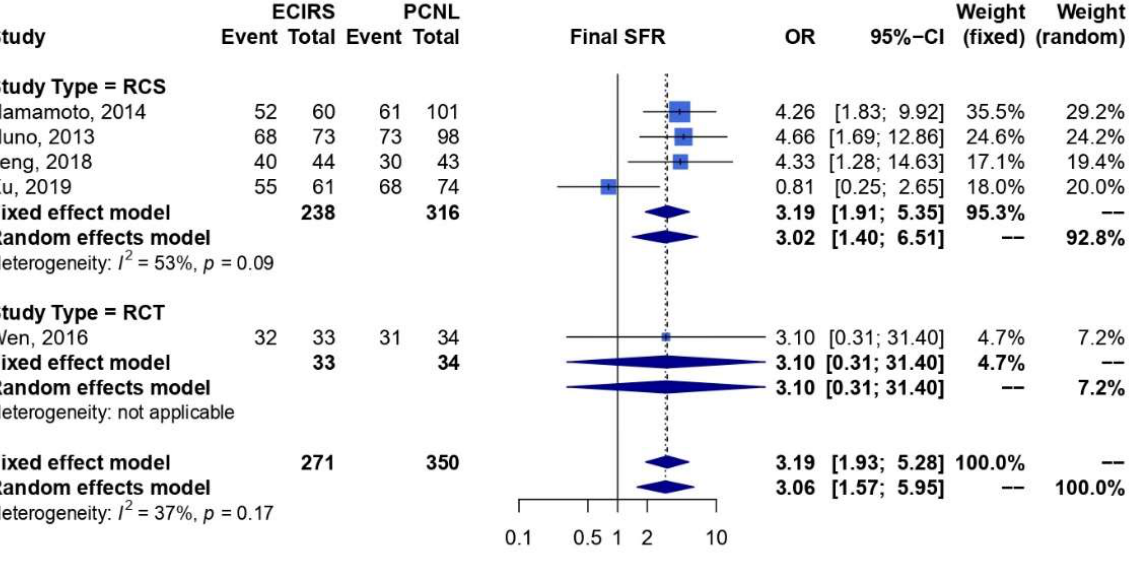
Figure A11. Subgroup analysis of outcome regarding final stone free rate. (RCS: [18–23]; RCT: [17])